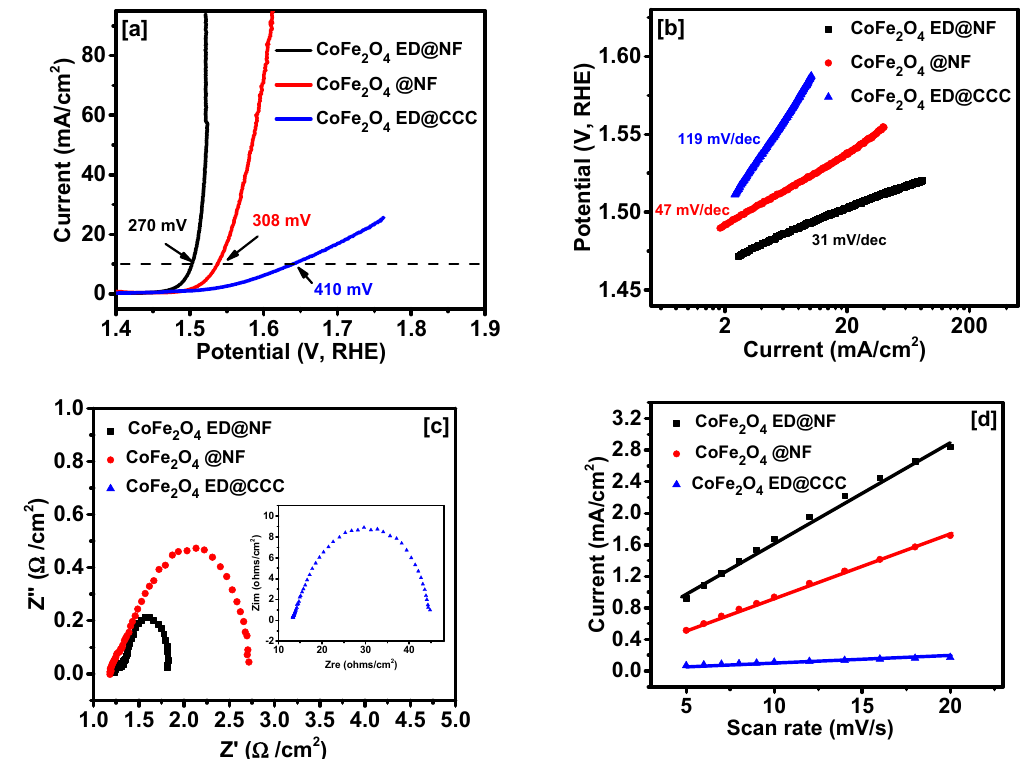
Figure 4. ( a ) Polarization curves, ( b ) Tafel slopes, ( c ) Nyquist plot at 0.5 V (vs. SCE), and ( d ) current density vs. scan rate plots for CoFe 2 O 4 electrodes. RHE—reversible hydrogen electrode; CCC—carbonized cotton cloth.